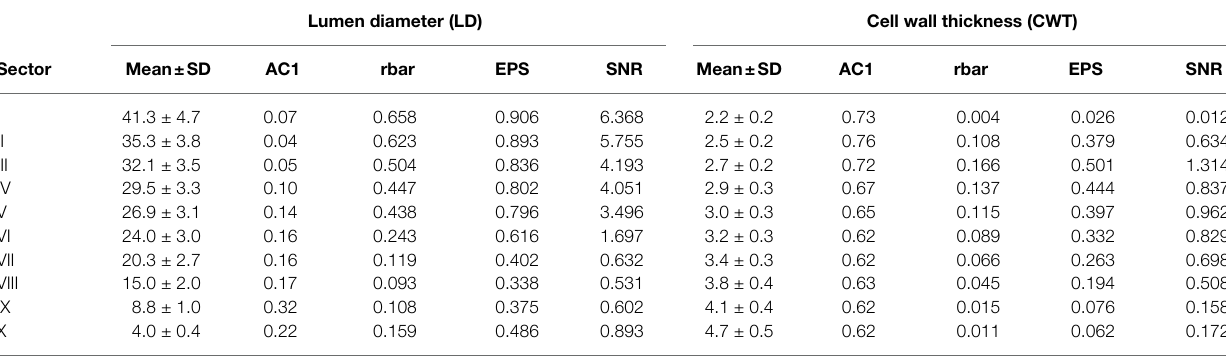
TABLE 1 | Summary statistics of cell lumen diameter and cell wall thickness chronologies. Lumen diameter (LD) Cell wall thickness